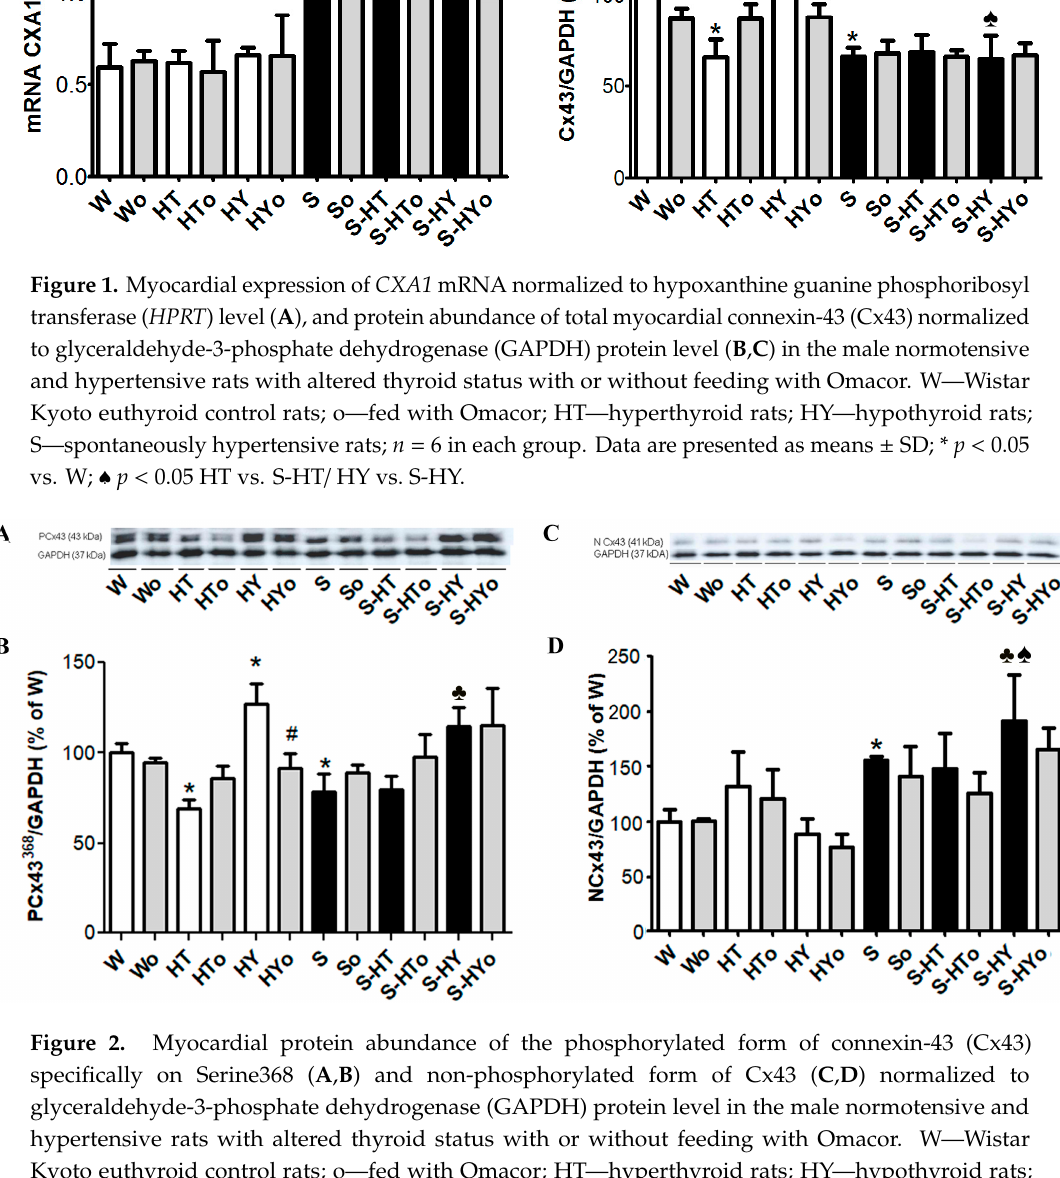
Figure 3. Topology of myocardial connexin-43 (Cx43, green) colocalized with N-cadherin (red) in the male normotensive rats with altered thyroid status with or without feeding with Omacor; W—Wistar Kyoto euthyroid control rats; o—fed with Omacor; HT—hyperthyroid rats; HY—hypothyroid rats. Note conventional immunofluorescence labeling of Cx43 and N-cadherin at the gap junctions (long arrows) and Cx43 on lateral surfaces of the cardiomyocytes (short arrows). Objective 40×, Scale bar 10 µm.